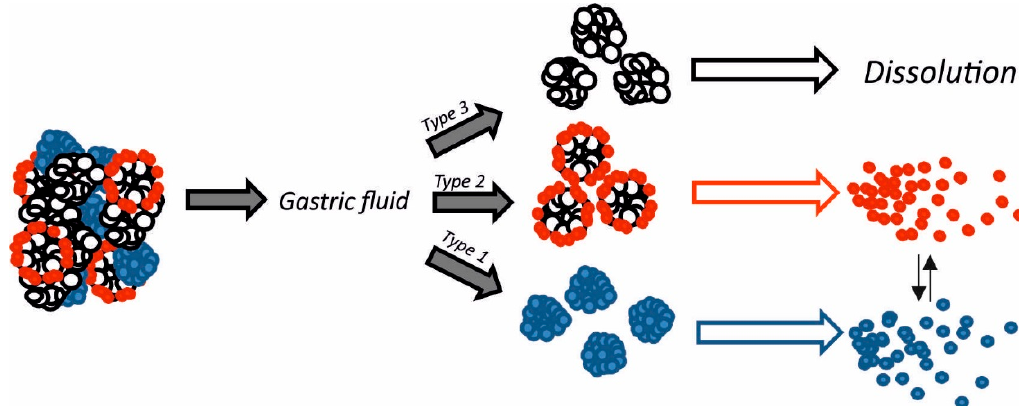
Figure 6. Scheme of hypothetical dissolution events that occur to Resv@MDH powder when it is in contact with simulated stomach fluids. Big powder aggregates divide into three main microparticles named as type 1, 2 and 3. In acidic milieu the type 3 microparticles of magnesium dihydroxide completely dissolves; type 1 microparticles (blue) dissolves in water solution together with type 2 microparticles (red). In this case the limiting step in resveratrol release could be related to acid erosion of dihydroxide core.